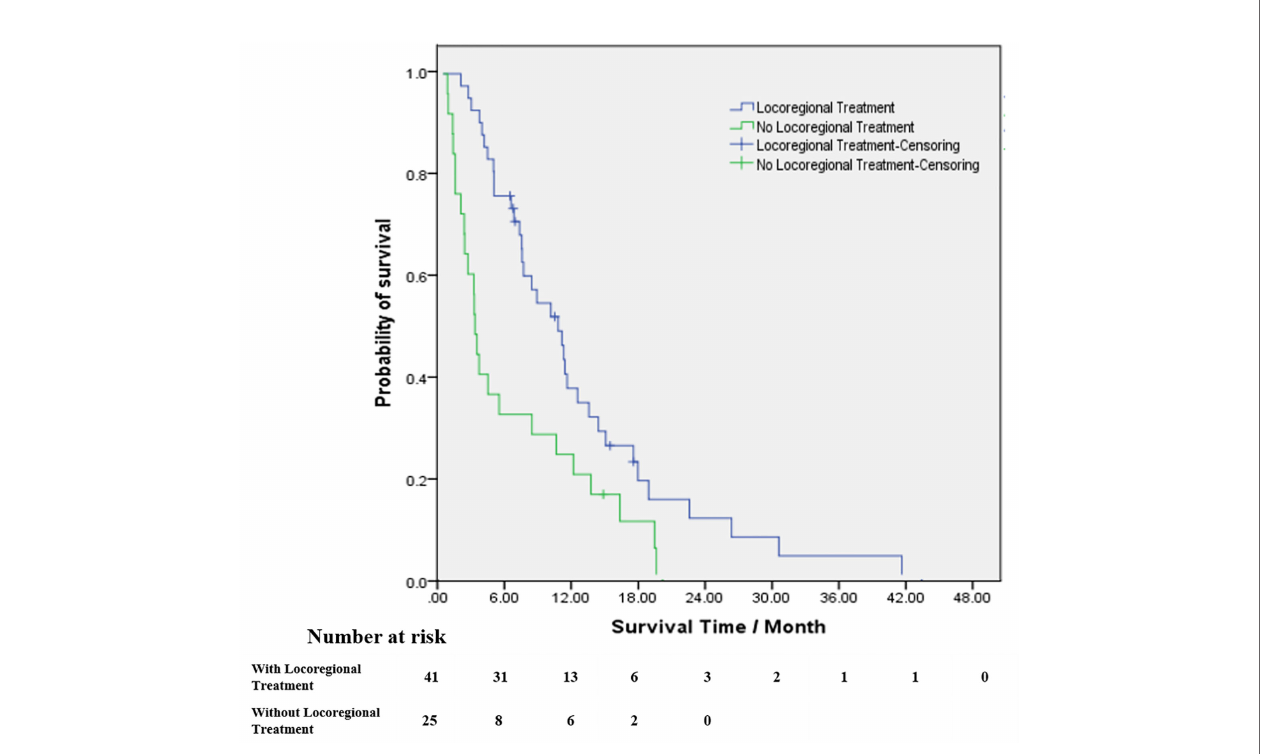
FIGURE 3 | Kaplan – Meier estimates of survival from the time of diagnosis of brain metastases among patients with brain radiotherapy (blue line) and patients without brain radiotherapy (green